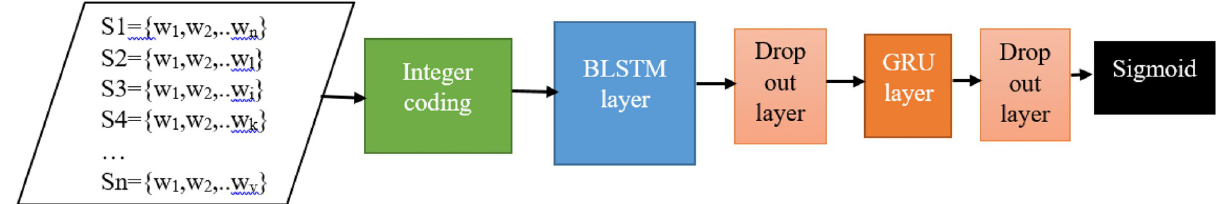
Fig 2. Proposed BLSTM-GRU network model for Amharic next word